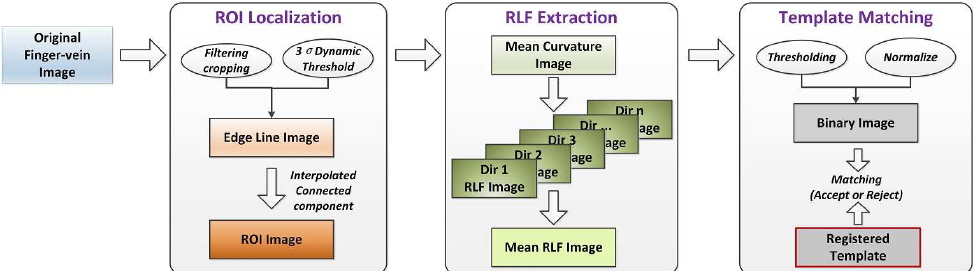
Figure 3. Block diagram of the proposed RLF-based feature extraction method for finger vein image recognition.